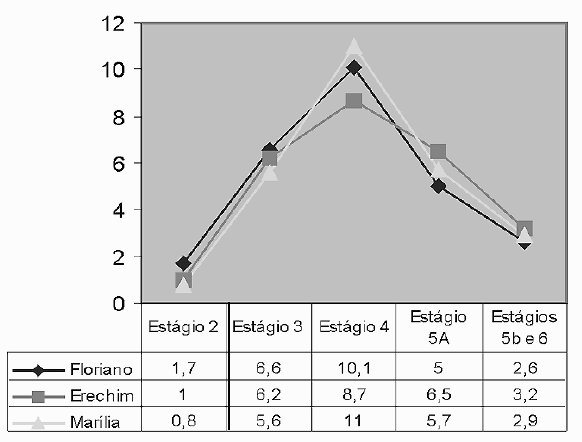
Figura 5. Pontua(cid:231)ªo mØdia bruta dos jovens brasileiros de Floriano/PI, Erechim/RS e Mar(cid:237)lia/SP no DIT-1.